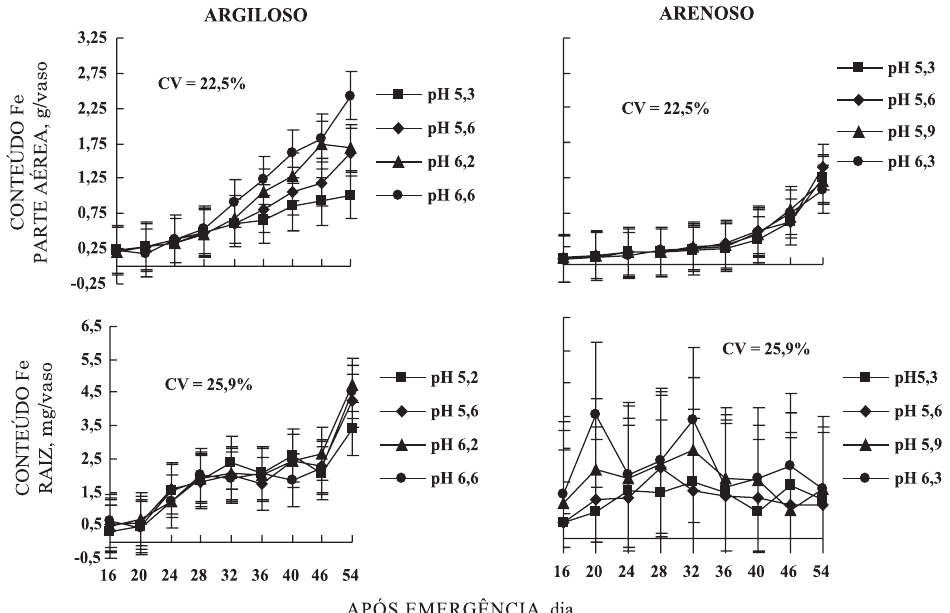
Figura 6. Conteúdo de ferro da matéria seca da parte aérea e do sistema radicular de plantas de soja, em diferentes épocas de avaliação após a emergência, em relação ao pH inicial do solo argiloso e do